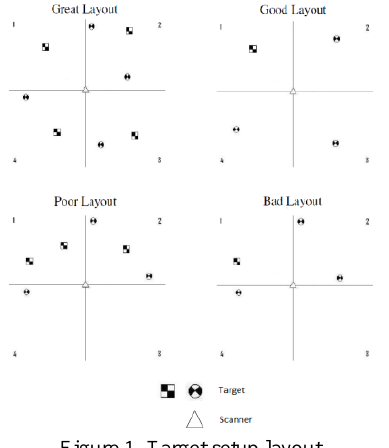
Figure 1. Target setup layout